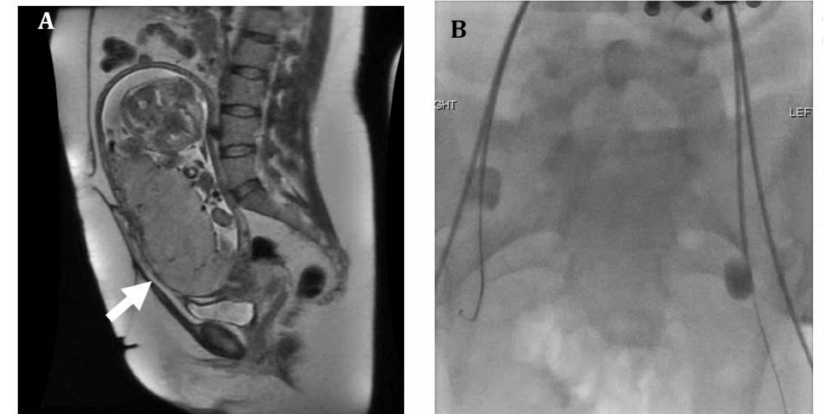
Figure 1. Thirty-three-year-old female with placenta accreta. ( A ) Sagittal SSFSE MR image shows a thickened placenta with abnormal lobulated contour and loss of myometrial thickness in the lower uterine segment (arrow), suggestive of placenta accreta. ( B ) Prophylactic bilateral internal iliac artery occlusion balloons were placed prior to hysterectomy. Patient underwent cesarean hysterectomy at 33 weeks with delivery of a healthy newborn. Pathology showed superficial attachment of the placenta to the uterine wall, consistent with placenta